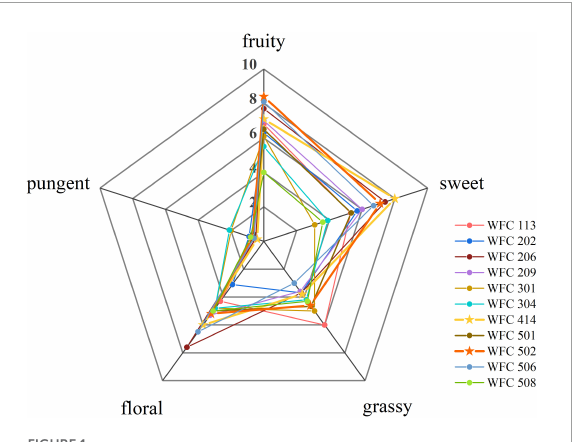
(24, 25). Besides, the aroma of the fermented fruit juice has a crucial influence on the character and marketability of the final product (26, 27). Therefore, the LAB from the pickles was isolated to select the strains with strong aroma production ability, high viable cell counts, and noticeable pH reduction in fermenting apple juice. Their aroma intensity, viable cells, and pH of the fermented apple juice were determined. A total of 80 strains of bacteria were isolated from four types of pickles purchased, and each strain was numbered. First, the odor of fermented apple juice for each strain was sniffed, in which 20 strains with an unpleasant odor, 17 strains with no apparent acceptable aroma, 32 strains with light